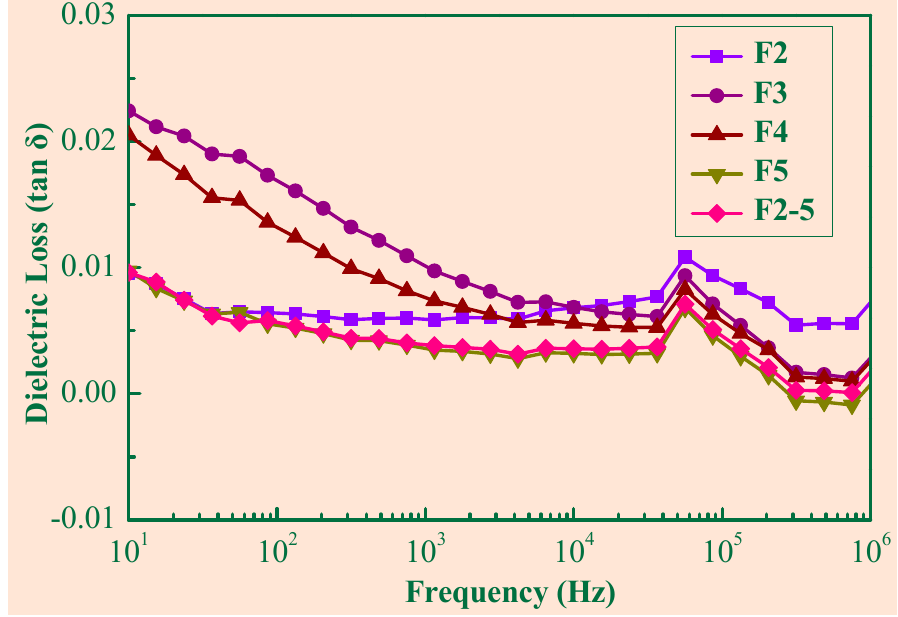
Figure 7. The dielectric loss of the SR/Gr composites (3 wt%).